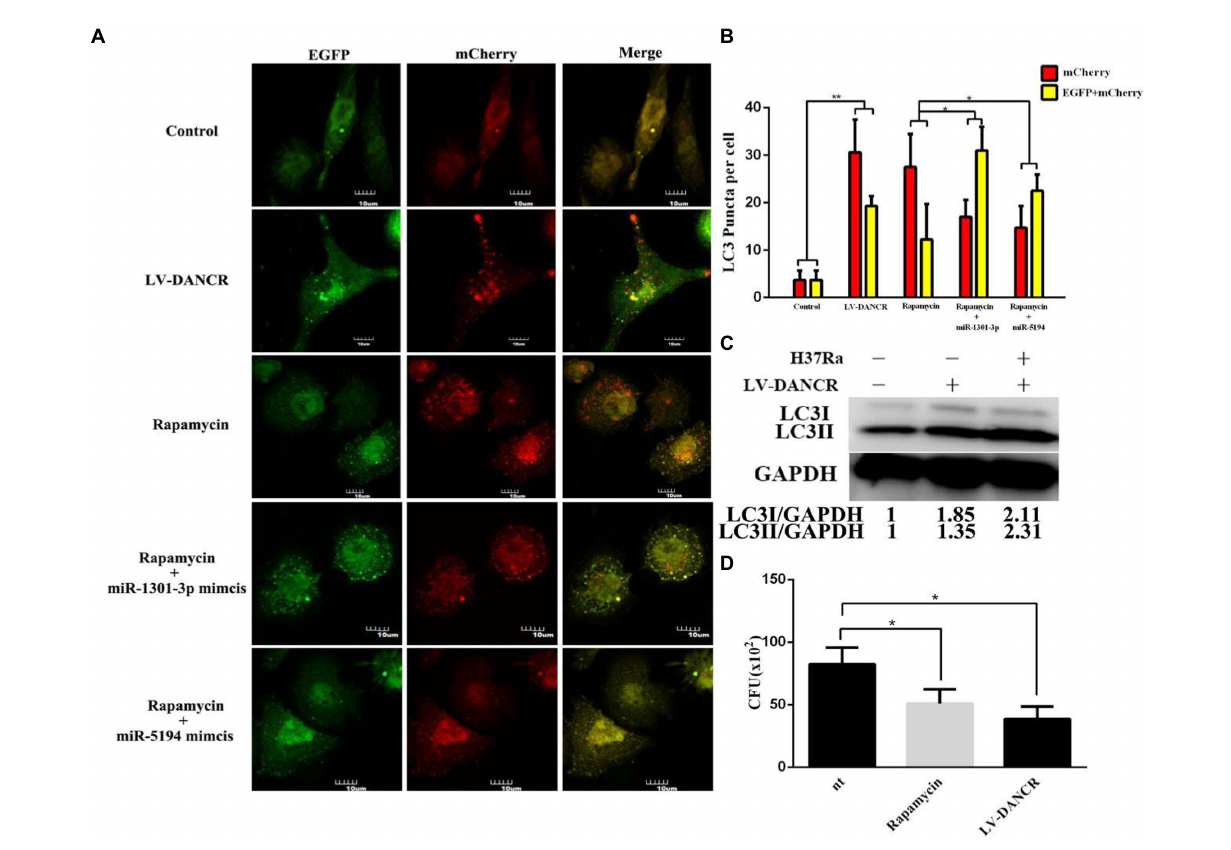
FIGURE 6 DANCR restrained the survival of intracellular MTB by inducing autophagy. (A) Normal THP-1 cells were transfected with lentivirus encoding EGFP- mCherry-LC3 plasmid to construct cellular models for autophagic flux detection. Afterward, the cell models were treated with PMA followed by lentivirus encoding DANCR, rapamycin, and rapamycin plus miR-1301-3p/miR-5194 mimics within 72 h, respectively. The images were captured at the magnification of 600. (B) The red or yellow puncta of LC3 in each group were counted from three different fields under the microscope and at least 10 cells. (C) The LC3 proteins in normal THP-1(lane 1), LV-DANCR cells (lane 2), and LV-DANCR cells infected with H37Ra (lane 3) were measured by Western blotting. (D) Normal THP-1 cells, rapamycin-pretreated THP-1 cells, and LV-DANCR cells were infected with H37Ra for 6 h. The cells were washed with PBS thoroughly to remove the extracellular H37Ra and cultured for another 18 h before being lysed. The cell fragments were inoculated on 7H10 agar plates, and the colony of H37Ra was counted 3 weeks later. Data represent the mean ± SD from three replications. A two-tailed Student’s t -test was used for statistical analysis. * p < 0.05 and ** p <